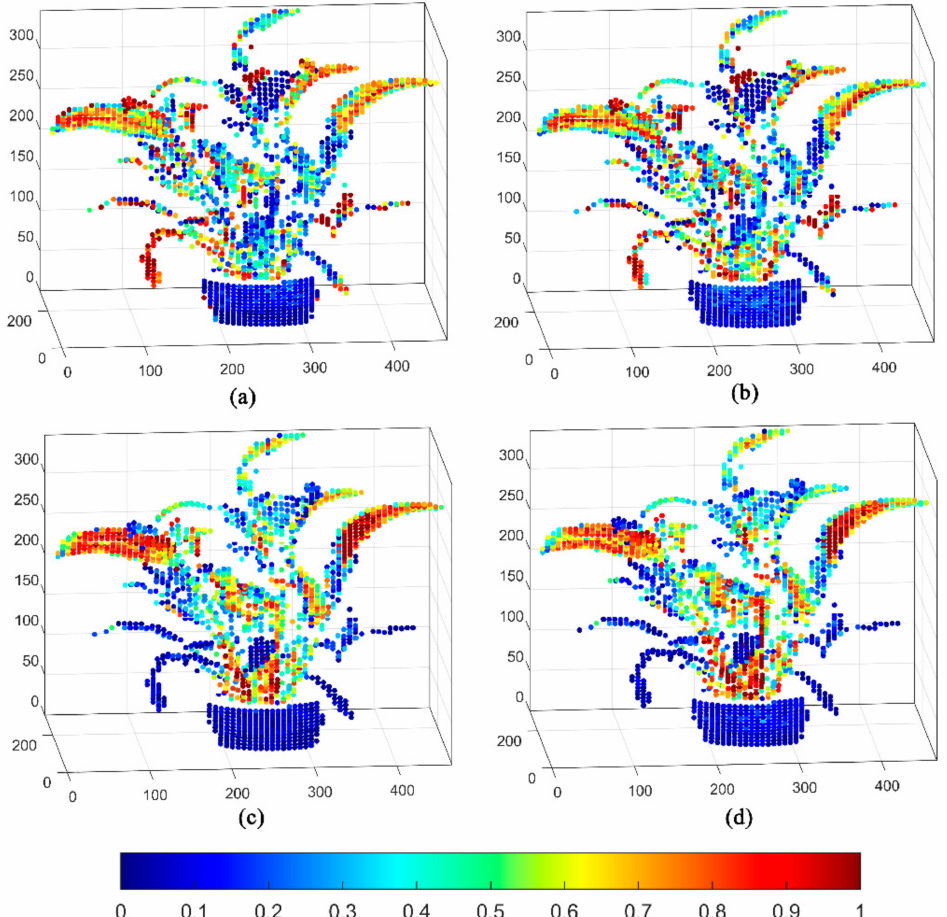
Figure 7. Single-wavelength fluorescence 3D imaging based on the Scene 2 scanning experiment of the MWFL system: ( a ) 460 nm, ( b ) 525 nm, ( c ) 685 nm, and ( d ) 740 nm wavelength signal intensity pseudo-color 3D imaging. The intensity values were subjected to HE and